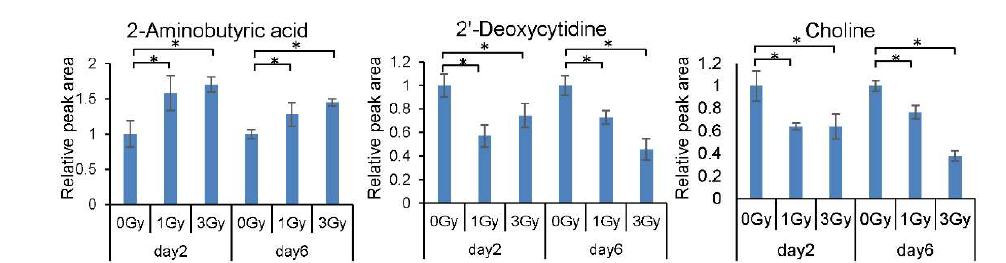
Figure 1. Dose and time response of levels of 2-aminobutyric acid, 2′-deoxycytidine, and choline in mouse blood cells. All quantitative data are means ± SD. * p < 0.05.